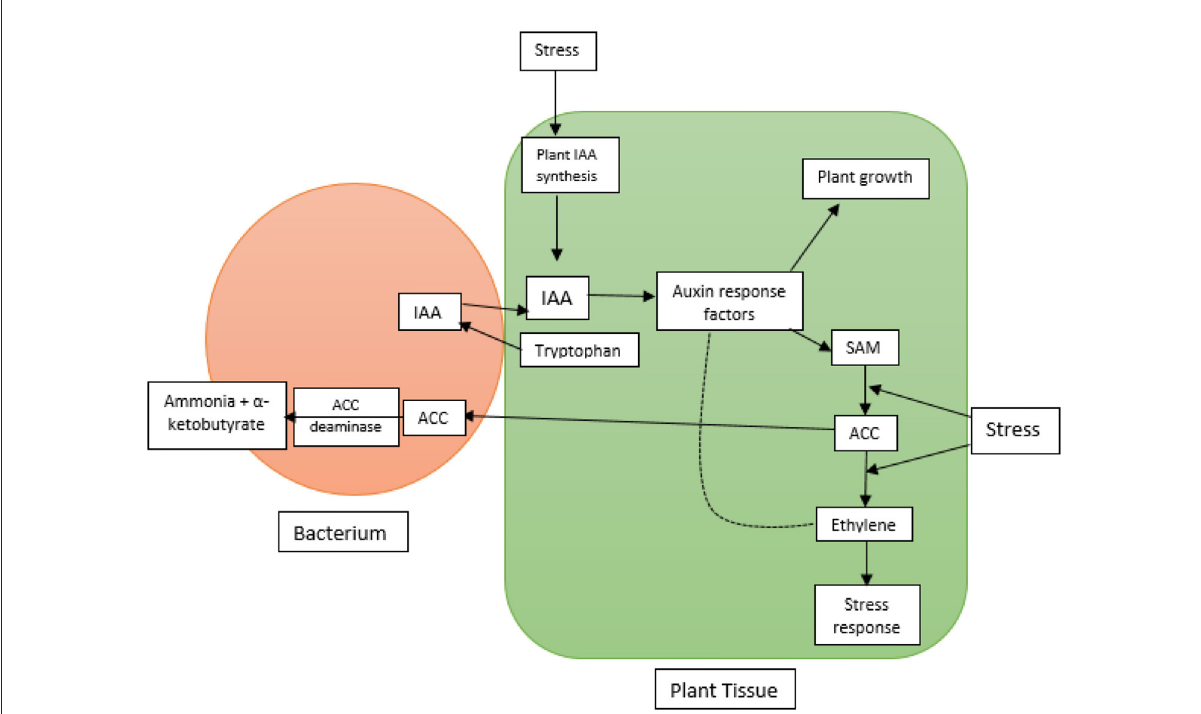
FIGURE3 The image above [as described by Glick (2014)] shows the bacteria-assisted production of ammonia and α -ketobutyrate through the action of ACC deaminase as a response to stress on plants. Abbreviations: ACC - 1-aminocyclopropane-1-carboxylate; IAA - indole acetic acid; SAM - S-adenosyl